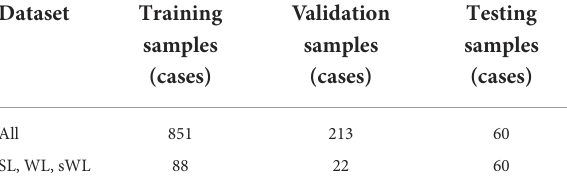
TABLE 1 Training, validation, and testing sample size for the proposed DeepHeartCT framework based on All, strong label (SL), weak label (WL), and synthetic weak label (sWL)